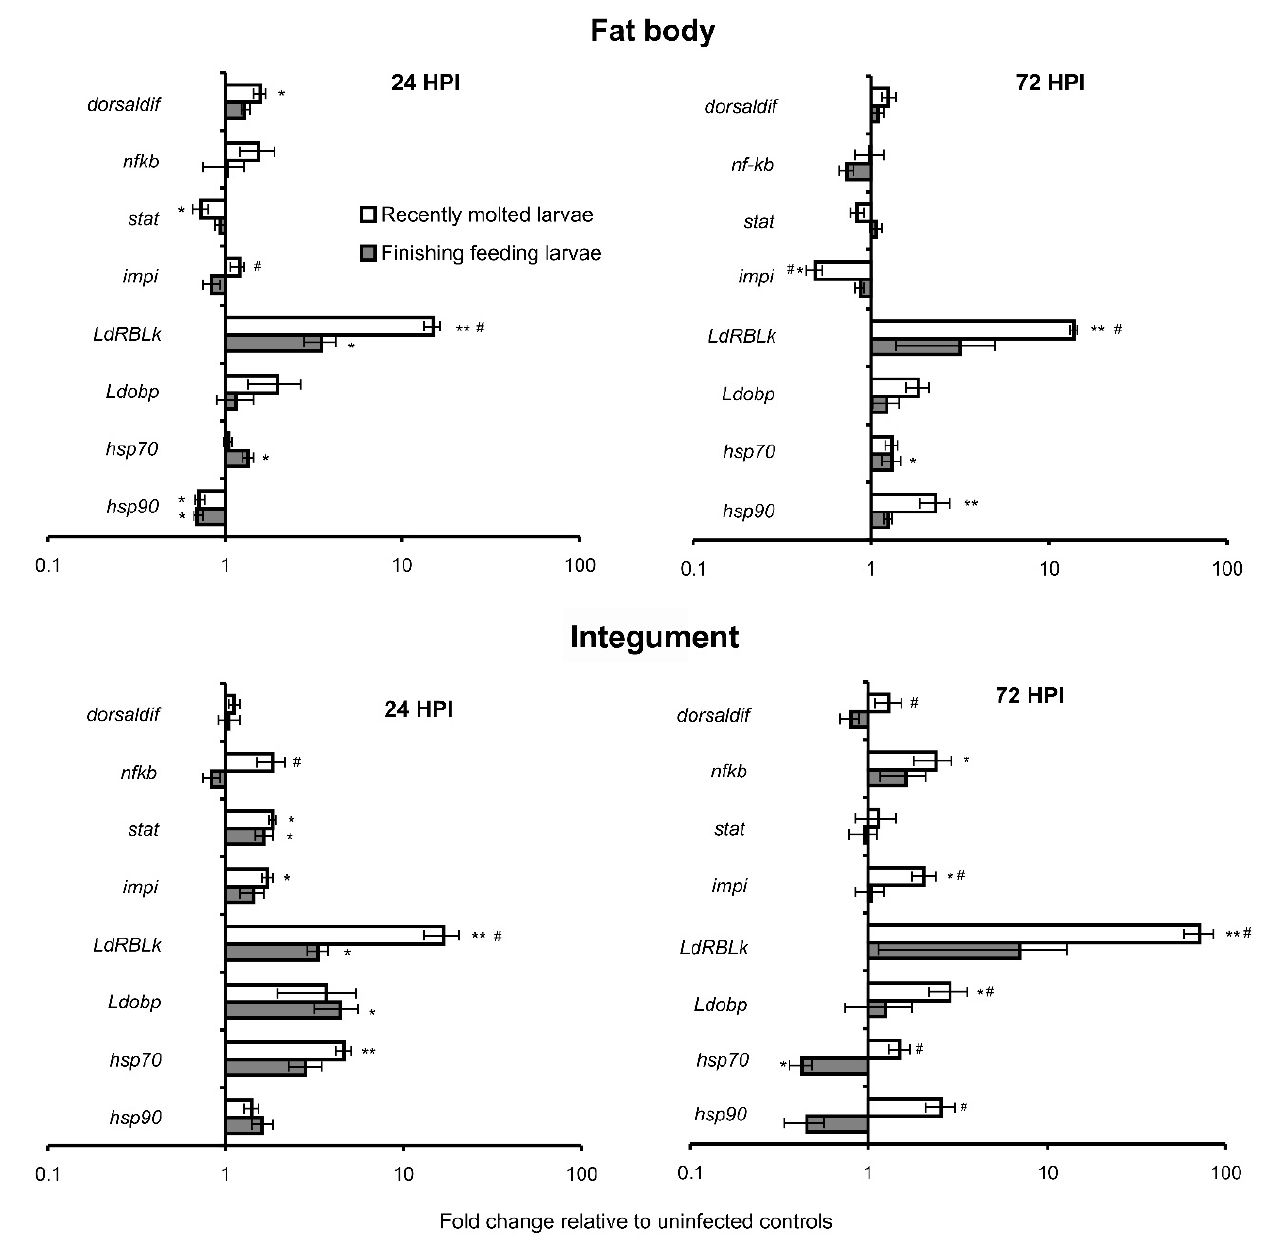
Figure 3. Alterations of expression of immunity- and stress-related genes in different stages of CPB larvae at 24 h post-inoculation (HPI) and 72 HPI with M. robertsii (5 × 10 6 conidia/mL). Data are presented as fold changes relative to an uninfected control in each stage at each time point. Genes rp18 , arf2 , and arf19 were used as references. * p < 0.05, ** p < 0.01 relative to uninfected controls (Dunn’s test). # Significant differences in expression between infected recently molted larvae and infected finishing feeding larvae (Dunn’s test, p < 0.05).